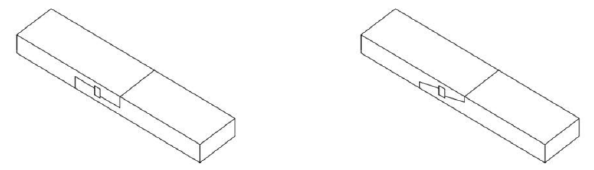
Figure 8. Models representing the geometry of scarf joints.